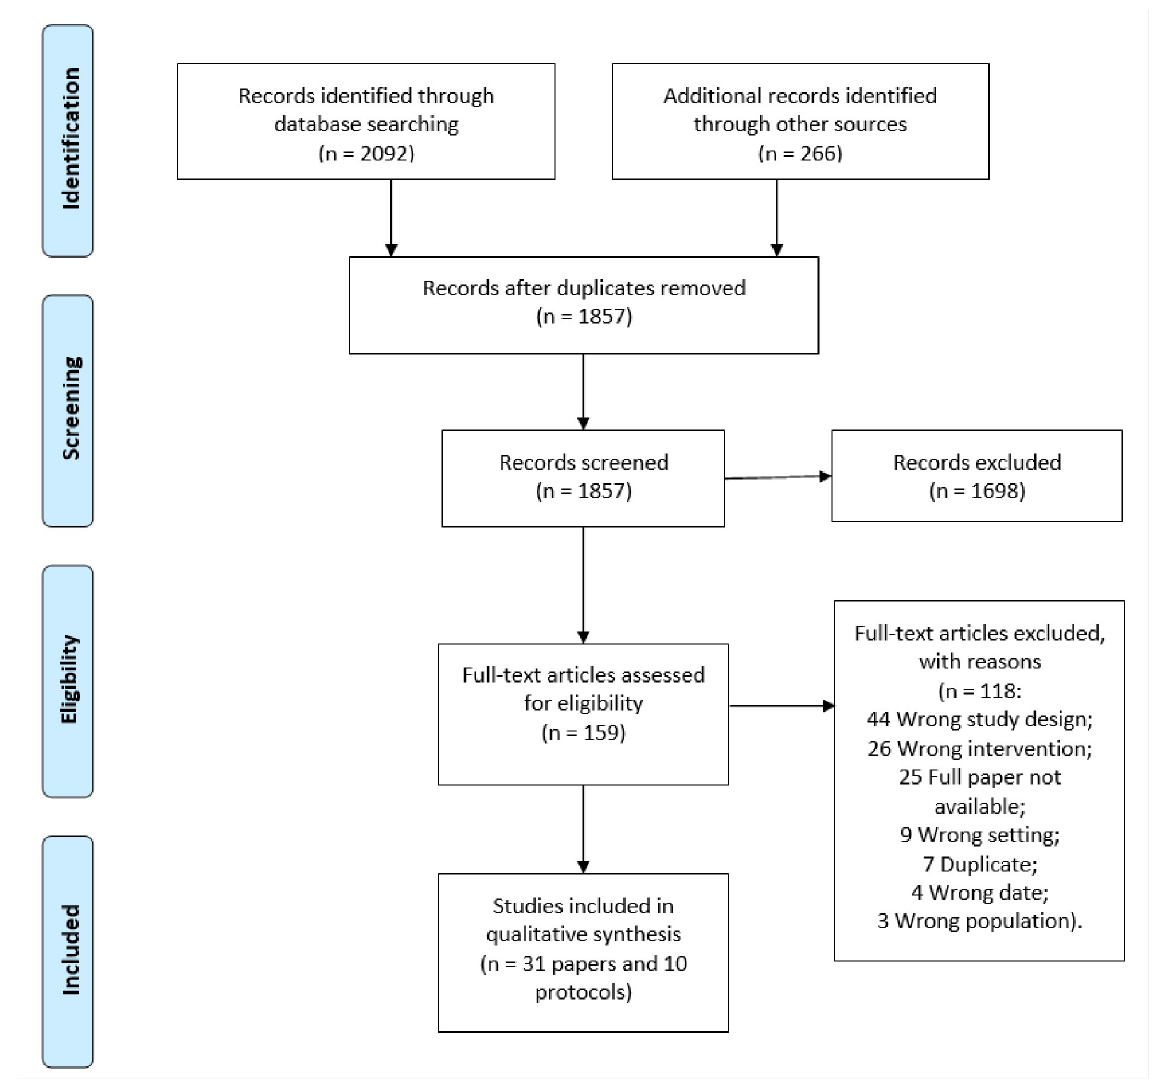
Fig 1. PRISMA 2009 flow